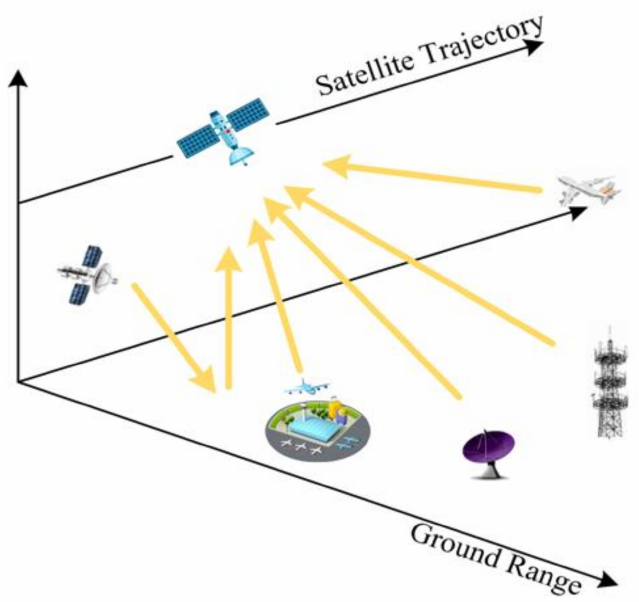
Figure 1. Common sources of